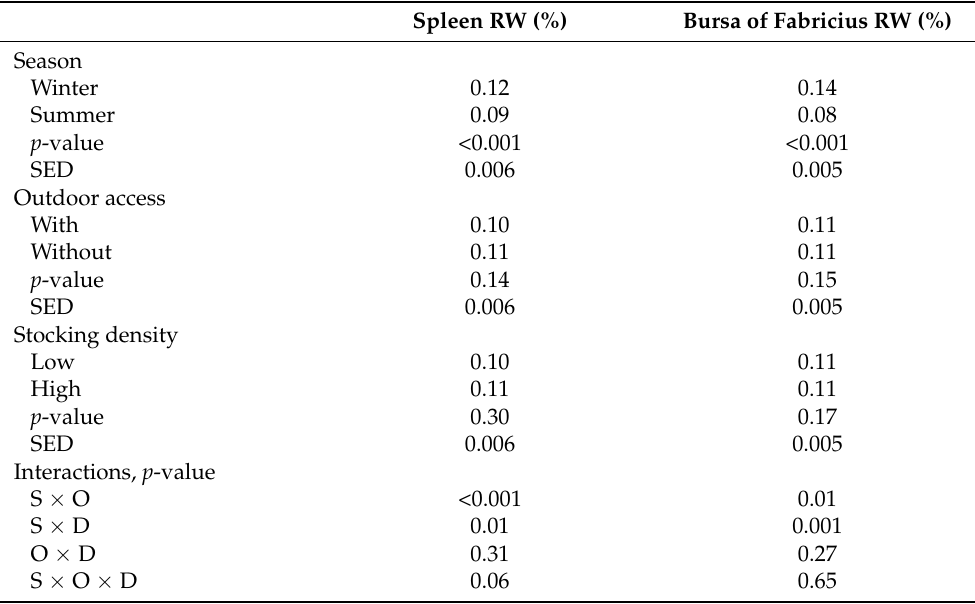
Table 9. Effects of season, outdoor access, and stocking density on the relative weight of lymphoid organs of Cobb500